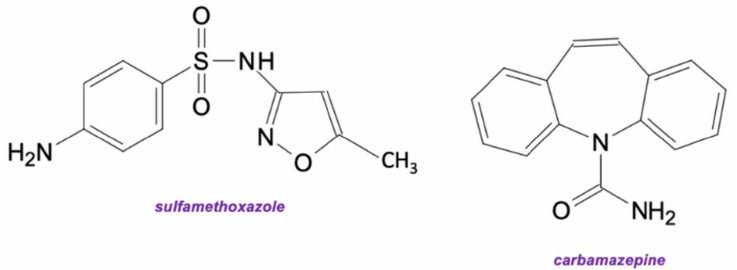
Figure 6. The structures of sulfamethoxazole and carbamazepine—pharmaceuticals used in the presented